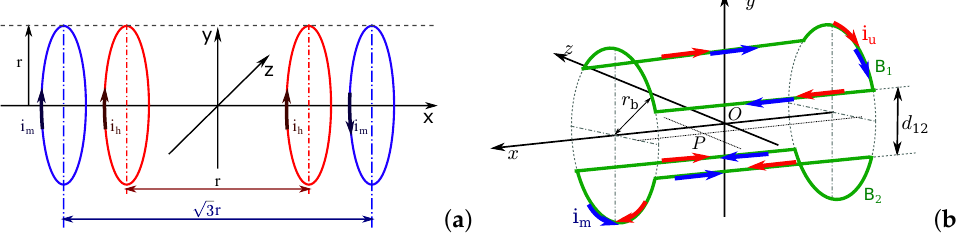
Figure 6. Basic electromagnets configurations: ( a ) representation of an Helmholtz (inner red) and Maxwell (outer blue) coils pair.; and ( b ) representation of saddle-shaped coils: with same current i u flowing in the uniform saddle coil, and current i g in phase opposite for the gradient saddle coil.